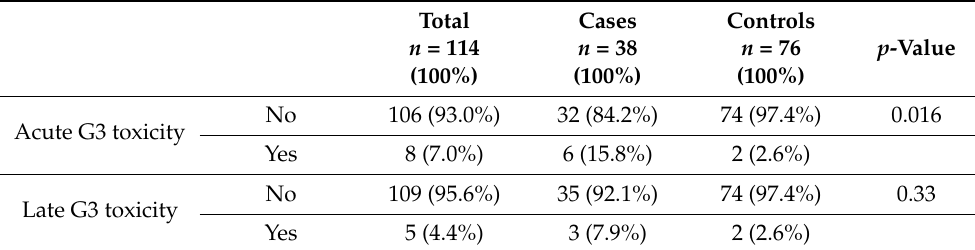
Table 2. High-grade toxicity in case (ADs) and control (no ADs)